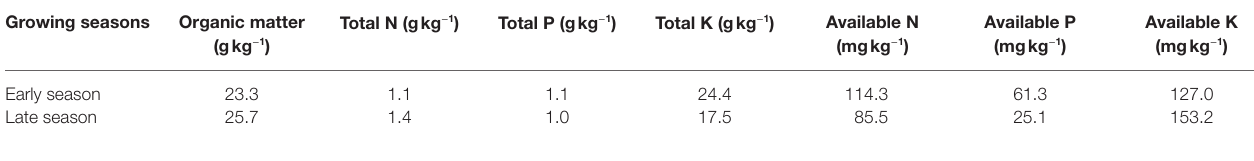
TABLE 1 | Properties of the experimental field soil during both the early and late seasons of the double rice cropping system in South China. Growing